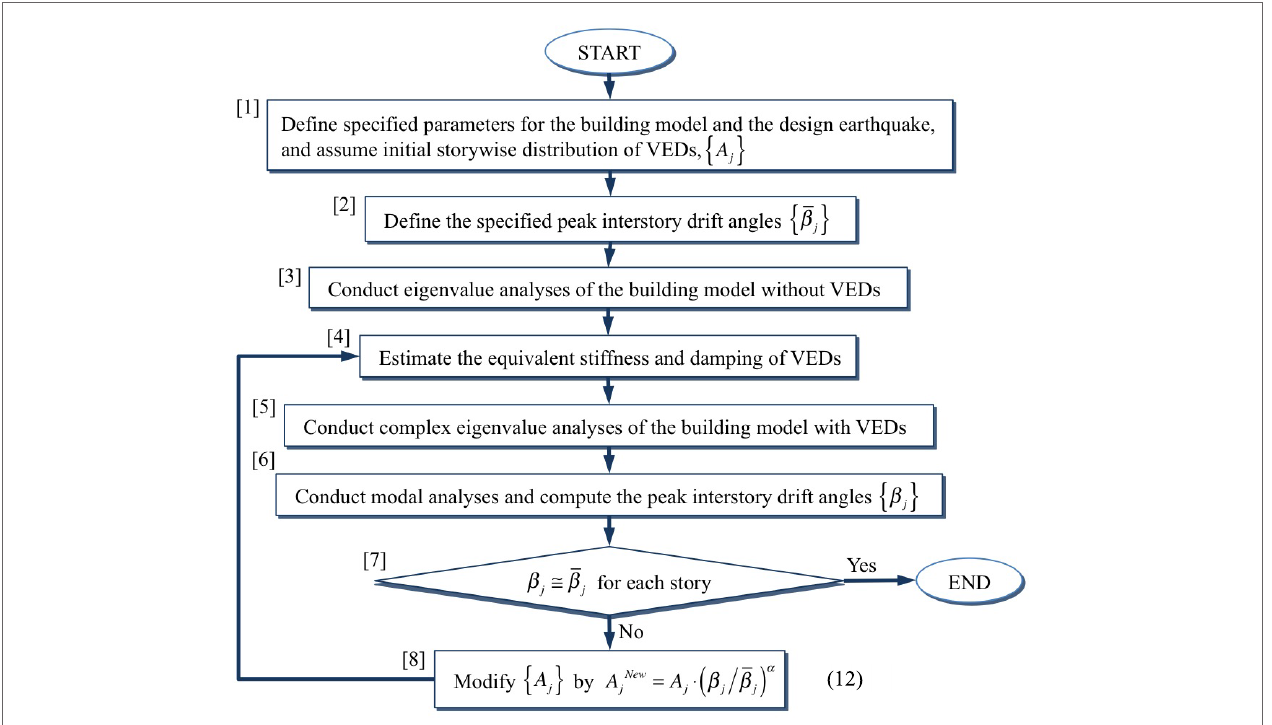
FIGURE 14 | Design process for placement design of VED for specified peak interstory drifts .